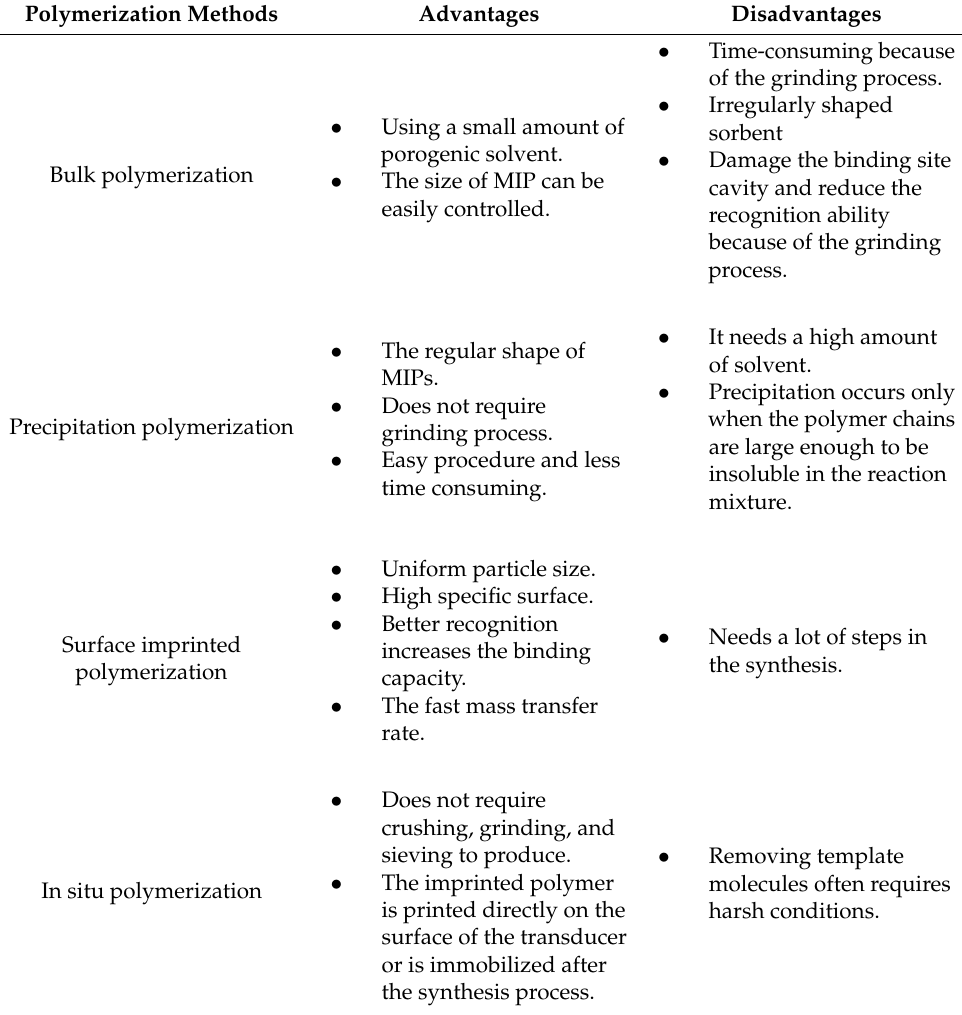
Table 7. Advantages and disadvantages of different polymerization